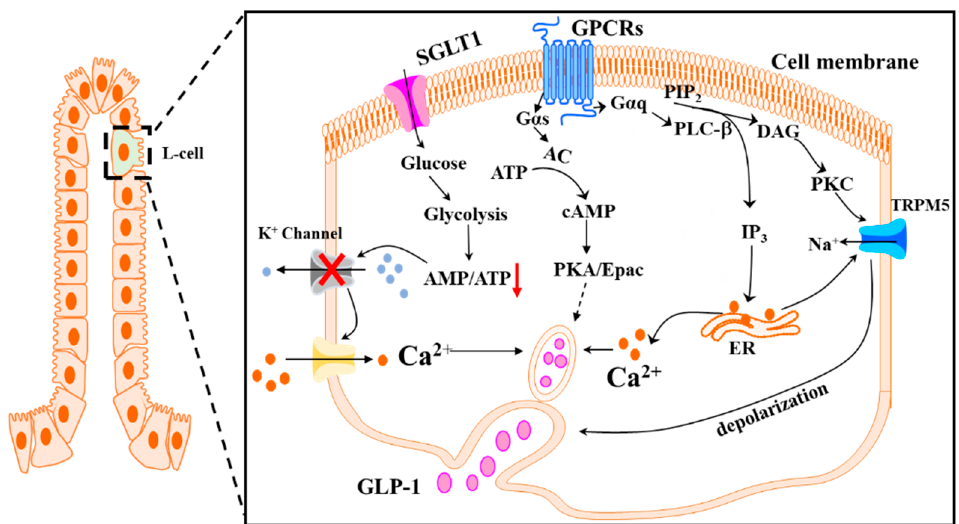
Figure 1. Schematic overview of nutrient-induced GLP-1 secretion from L-cells. AC: adenylyl cyclase; DAG: diacylglycerol; GLP-1: glucagon-like peptide-1; GPCRs: G-protein coupled receptors; IP3: inositol trisphosphate; PLC- β : phospholipase C- β ; PKA: protein kinase A; PKC: protein kinase C; PIP2: phosphatidylinositol 4,5-biphosphate; SGLT1: sodium/glucose co-transporter 1; TRPM5: transient receptor potential channel M5.